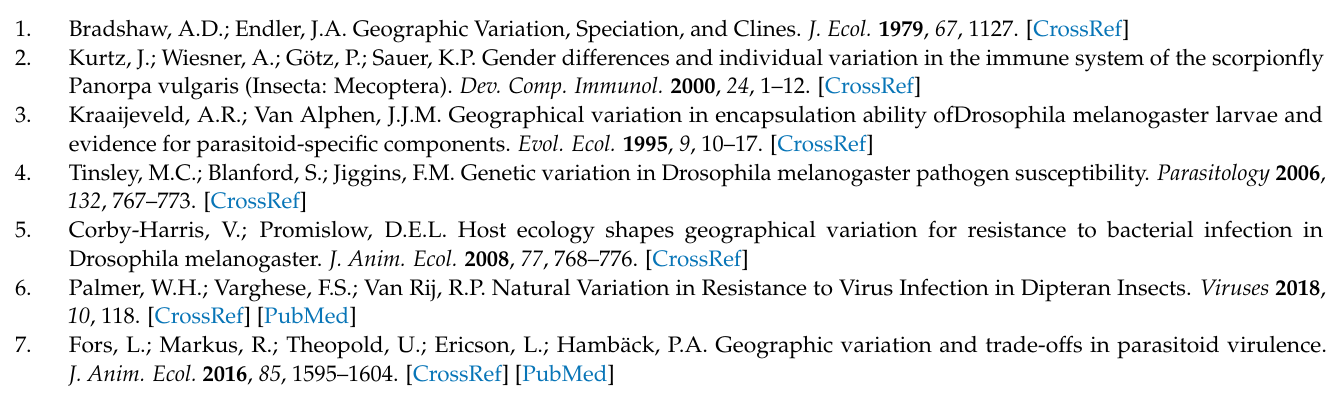
per gene, right per SNP. The red line denotes the averages of these values for the phagocytosis genes, Table S1: Test Statistics for total hemocyte count by sex and population, Table S2: Test Statistics for total number of Phagocytosing cells, Table S3: Averages of proportion of phagocytic cell types by sex and population in percentages M= average, SD = standard deviation, Table S4: Test Statistics for proportion of Granulocytes between populations and sex, Table S5: Test Statistics for proportion of Plasmatocytes between populations and sex, Table S6: Test Statistics for proportion of Oenocytoids between populations and sex, Table S7: Test Statistics for total number of phagocytosing cells between population and sex, Table S8: Test statistics for proportion of phagocytes between population and sex as measured by flowcytometry, Table S9: Test Statistics for proportion of phagocytosing granulocytes, Table S10: Test Statistics for proportion of phagocytosing plasmatocytes, Table S11: Test Statistics for proportion of phagocytosing oenocytoids, Table S12: Test Statistics for propensity of granulocytes to perform phagocytosis, Table S13: Test Statistics for propensity of plasmatocytes to perform phagocytosis, Table S14: Test Statistics for propensity of oenocytoids to perform phagocytosis, Table S15: Distribution of F ST values G stands for genome-wise values, whereas P is the phagocytosis genes values, Table S16: The significant GO terms with p < 0.01 of the SNPs with the highest 2.5% values (exons only), Table S17: The GO terms with terms with p < 0.01 of the SNPs with the highest 2.5% FST values (with 5kb both